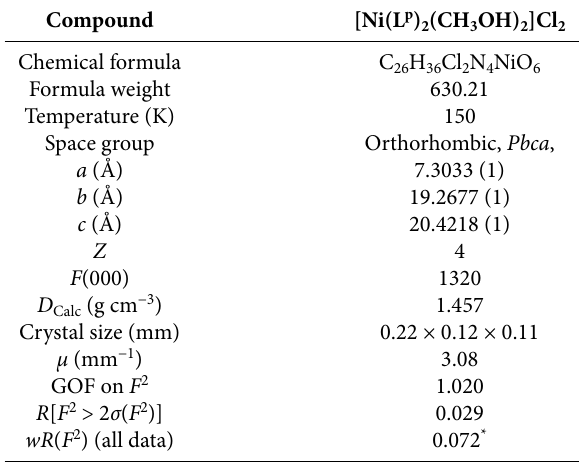
Table 1. Crystallographic data of the complex 1